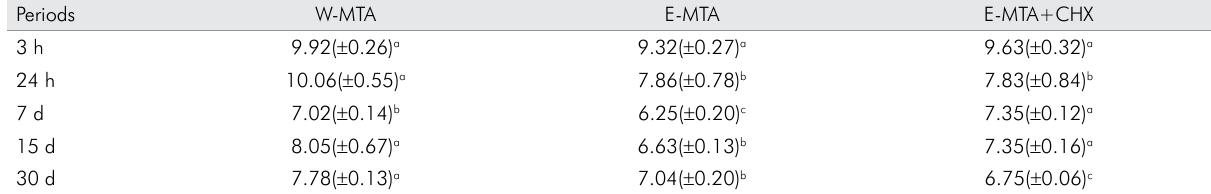
Table 2. pH values (mean ± standard deviation, n = 5 for each material) of soaking water after immersion of the samples in different evaluation periods (3 h to 30 days).